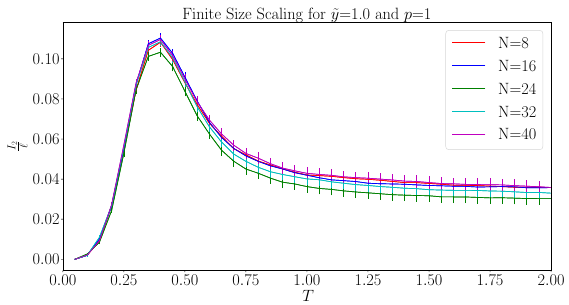
Figure 13 . RMI for p = 1 and ~ y = 1. This case corresponds to dYM(F). Unlike the previous cases, RMI of di(cid:11)erent sizes does not show any features of a phase